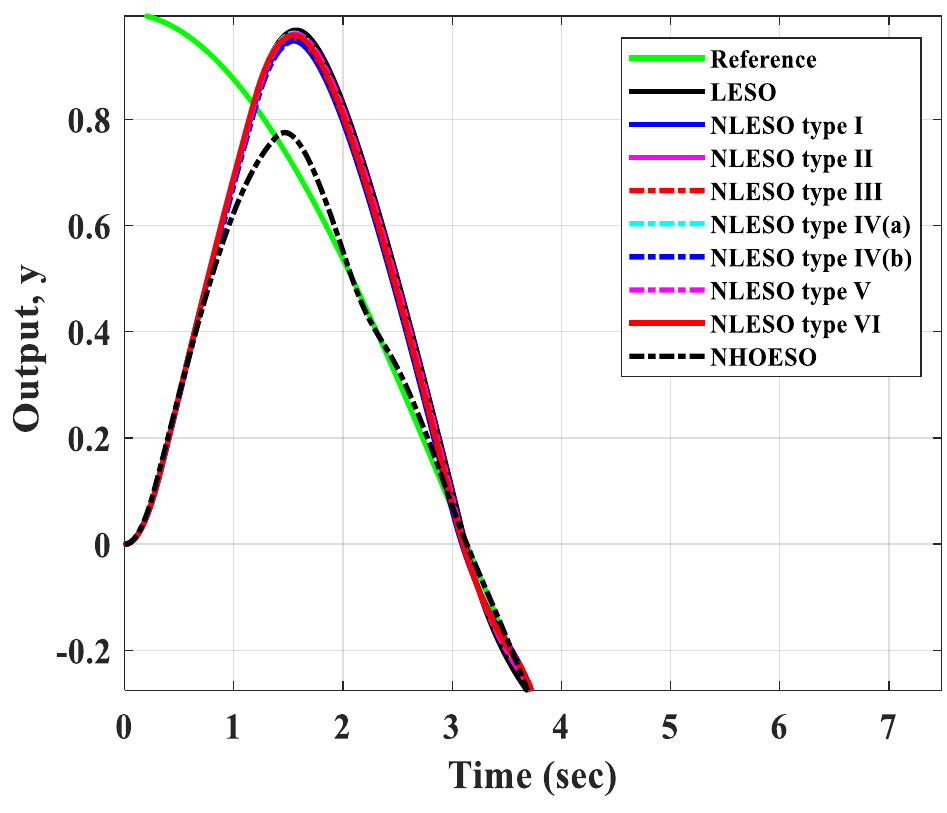
Figure 2. A magnified area of Figure 1.